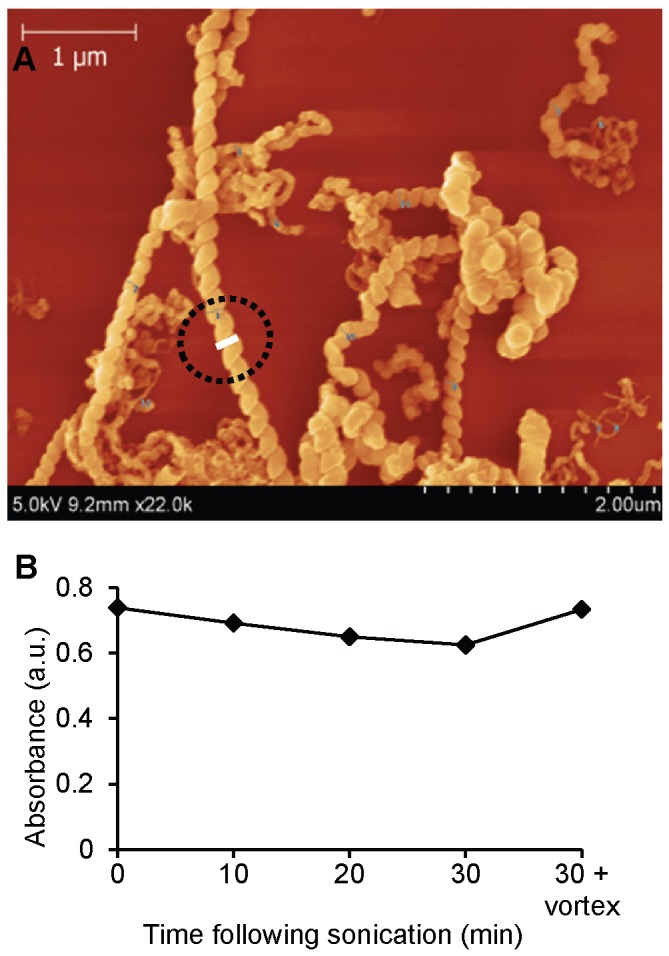
HCNTs resuspended in 0.01% Tween-80 are adequately dispersed prior to use.(A) A representative SEM image of HCNTs shows moderate variability in the diameter of individual tubes as well as sharp kinks and folding. The circled area highlights the diameter measurement using Gwyddion software (see supporting information). (B) Absorbance as a measurement of dispersion following 5 minutes of sonication. The decrease in absorbance over time is from dispersed HCNTs settling by gravity. A brief vortexing resuspends the HCNTs.